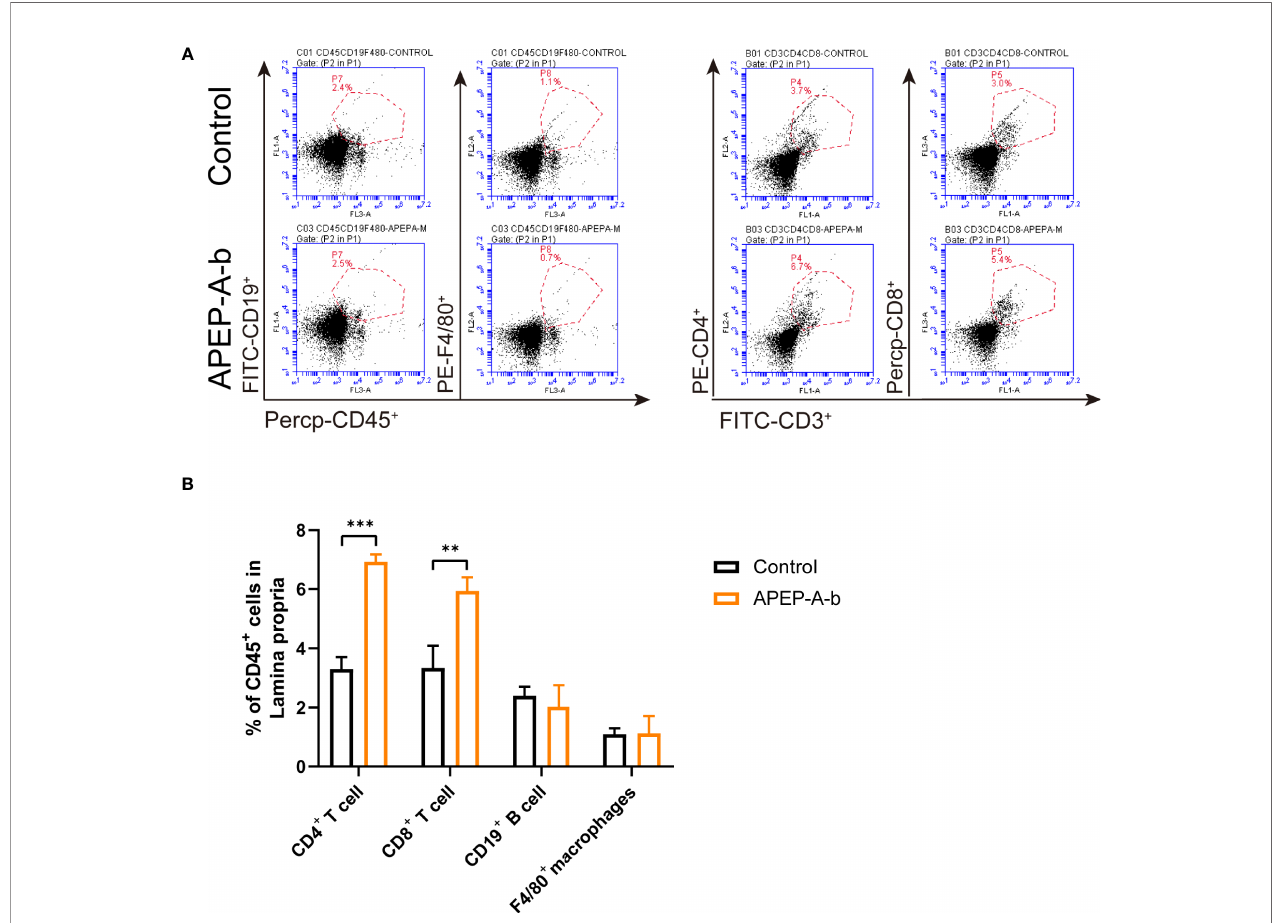
FIGURE 3 | APEP-A-b changed the proportion of immune cells in lamina propria. Flow cytometric analysis of CD4 + T cells (CD45.2 + CD3 + CD4 + ), CD8 + T cells (CD45.2 + CD3 + CD8 + ), B cells (CD45.2 + CD19 + ), macrophages (CD45.2 + F4/80 + ) and dendritic cells (CD45.2 + Ly6G + ) in the lamina propria of Control group (upper panels) and APEP-A-b 200 mg/kg·d group (lower panels). Representative dot plots (A) and summary data (B) depict of the frequencies of cell subsets. Data are represented as the means ± SD (n = 6). **P < 0.01 and ***P < 0.001 compared with the Control